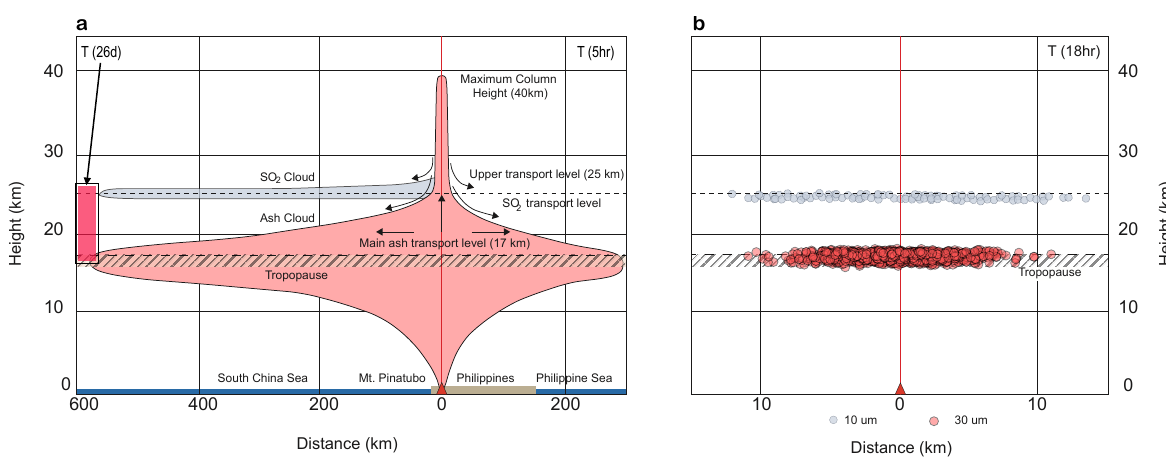
Figure 6. ( a ) Schematic longitudinal section through Pinatubo ash cloud at 5hr, based on Fero et al. [17]. Semitransparent box on left labeled ’T(26d)’ shows range of volcanic cloud heights after 26 days according to Winker and Osborn [8]. ( b ) Cross section through Lagrangian dispersion model for 10 and 30 µ m particles (Table 4) with turbulence layered atmosphere, showing layered ash dispersal. In other experiments with particles 1–10 µ m and 30–100 µ m, output was similar to that for 10 and 30 µ m, respectively.